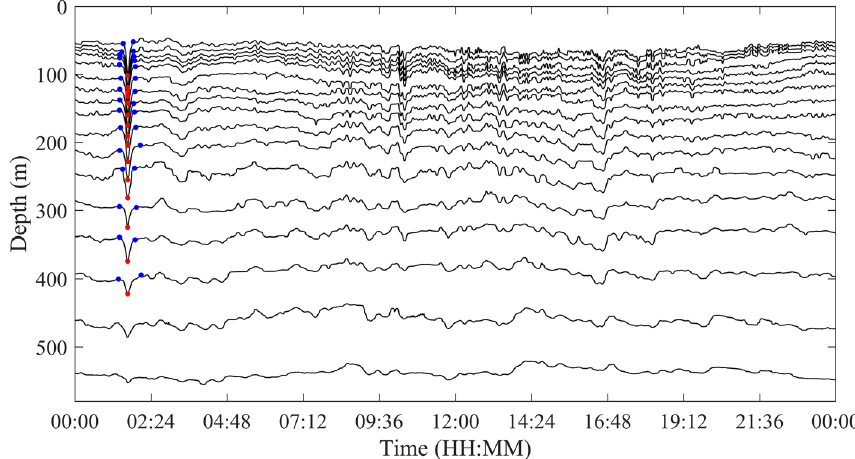
Figure 6. Schematic of identification of ISWs by WCI method on July 29, 2018. The black lines are the isotherms from 8 to 24 °C, the red dots correspond to the time when the amplitude of the ISW is the largest, and the blue dots to the left and right of the red dots are the start and end time of the ISW, respectively.